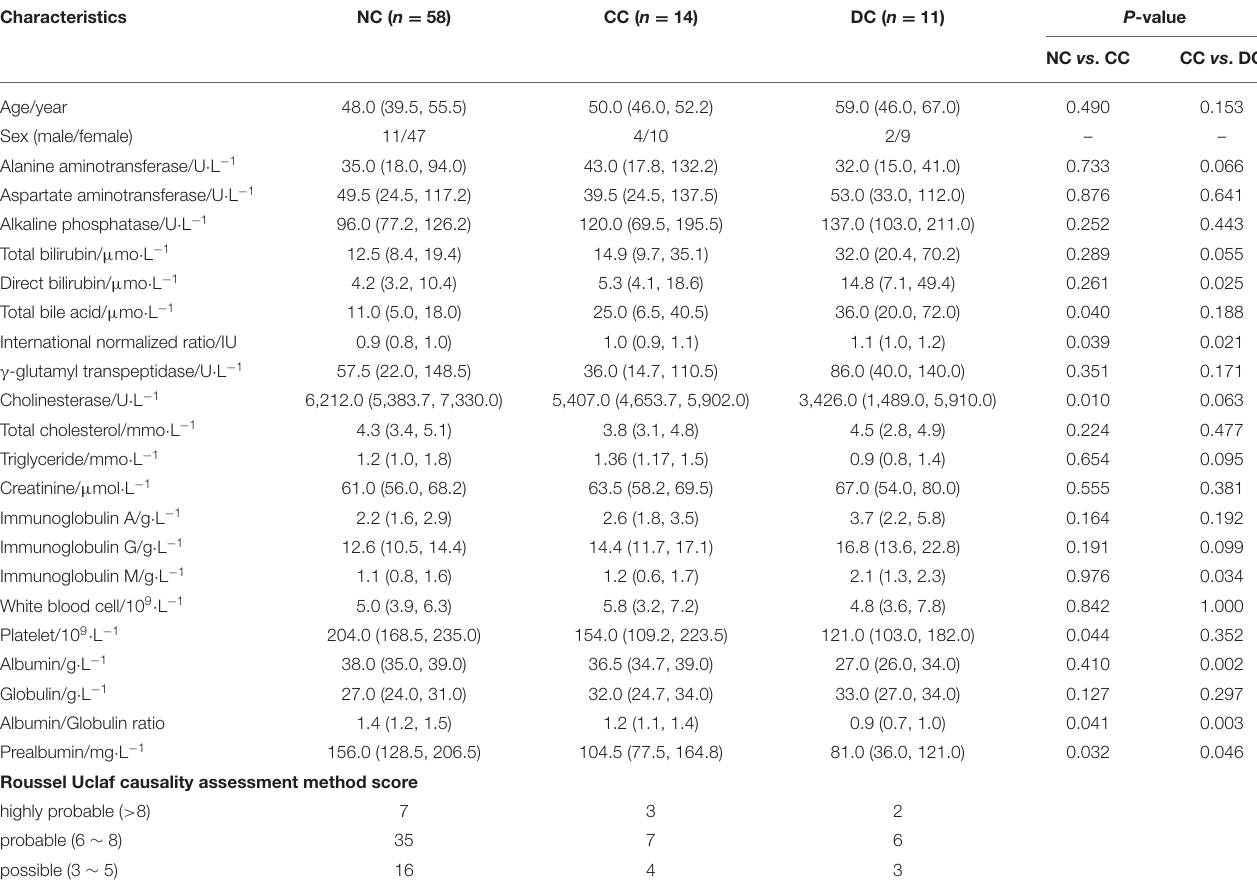
TABLE 1 | Clinical characteristics of chronic DILI patients in NC, CC, and DC groups.